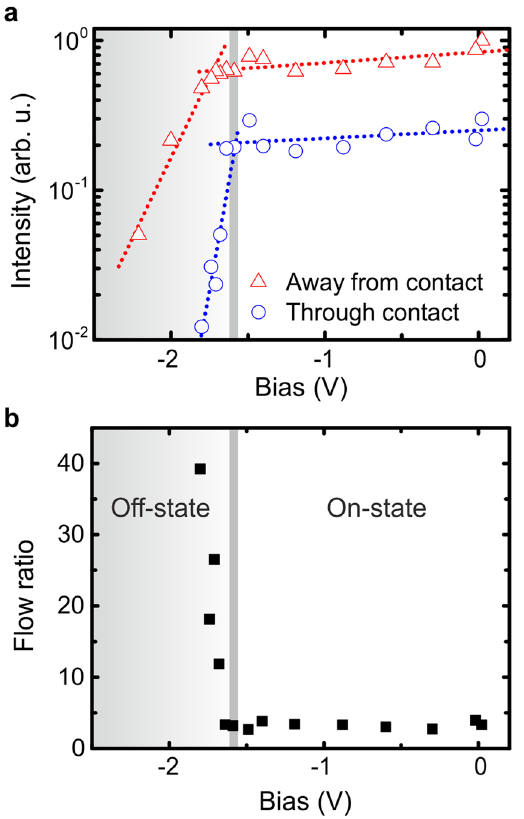
Figure 3. Quantitative analysis of the switching process. ( a ) Spatially integrated emission of the propagating polariton condensate away from the contact (red triangles) and through the contact (blue circle) for an excitation power of 20 mW. The center of the excitation spot is approximately 15 µ m away from the center of the 10 µ m wide electrical contact. Dotted lines are guides to the eye. The emission is integrated over a range of ~40 µ m along the length of the wire, starting at a distance approximately 20 µ m away from the excitation spot, and over the whole width of the wire (cf. schematic drawings in Fig. 2). With increasing negative voltage the flow in both directions decreases continuously. At a voltage of U G = − 1.60 V the flow through the contact shows a sharp intensity drop, while the flow away from the contact shows a slighter drop at around U G = − 1.72 V. ( b ) Corresponding ratio between the flow away and through the contact. A sharp increase of the ratio is visible at around U G = − 1.64 V, indicating the ‘off-state’ of the flow